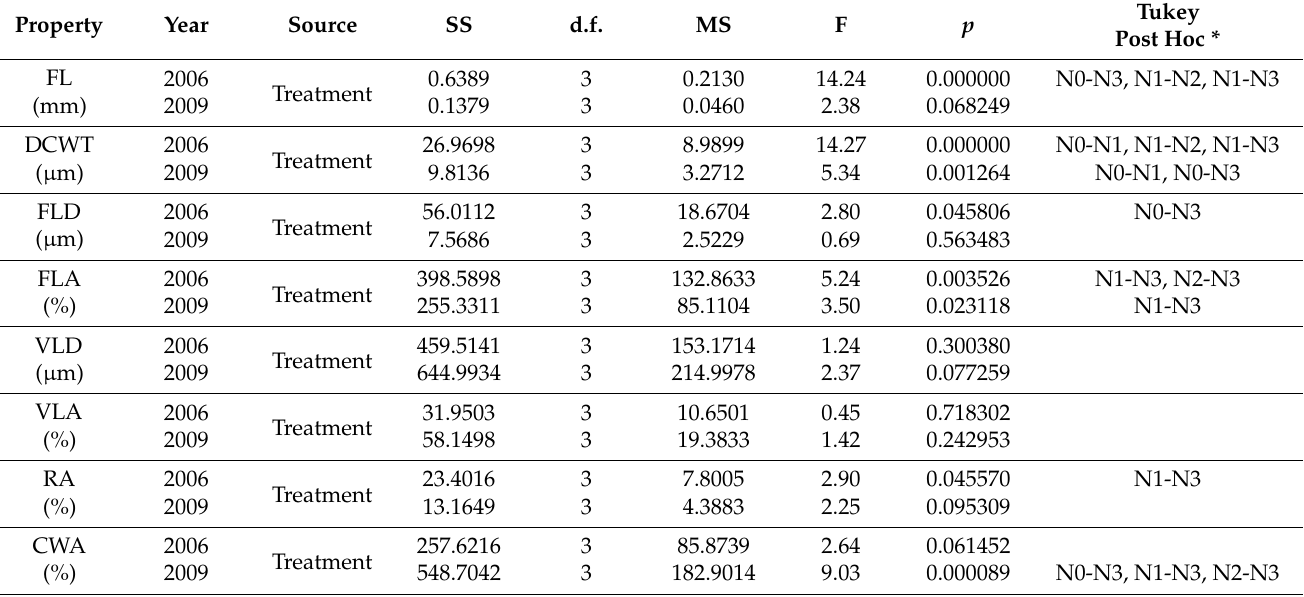
Table 4. Results of repeated measures analysis of variance ANOVA for the anatomical properties of the juvenile wood of the clone ‘Villafranca’ in two years (2006 and 2009) after nitrogen